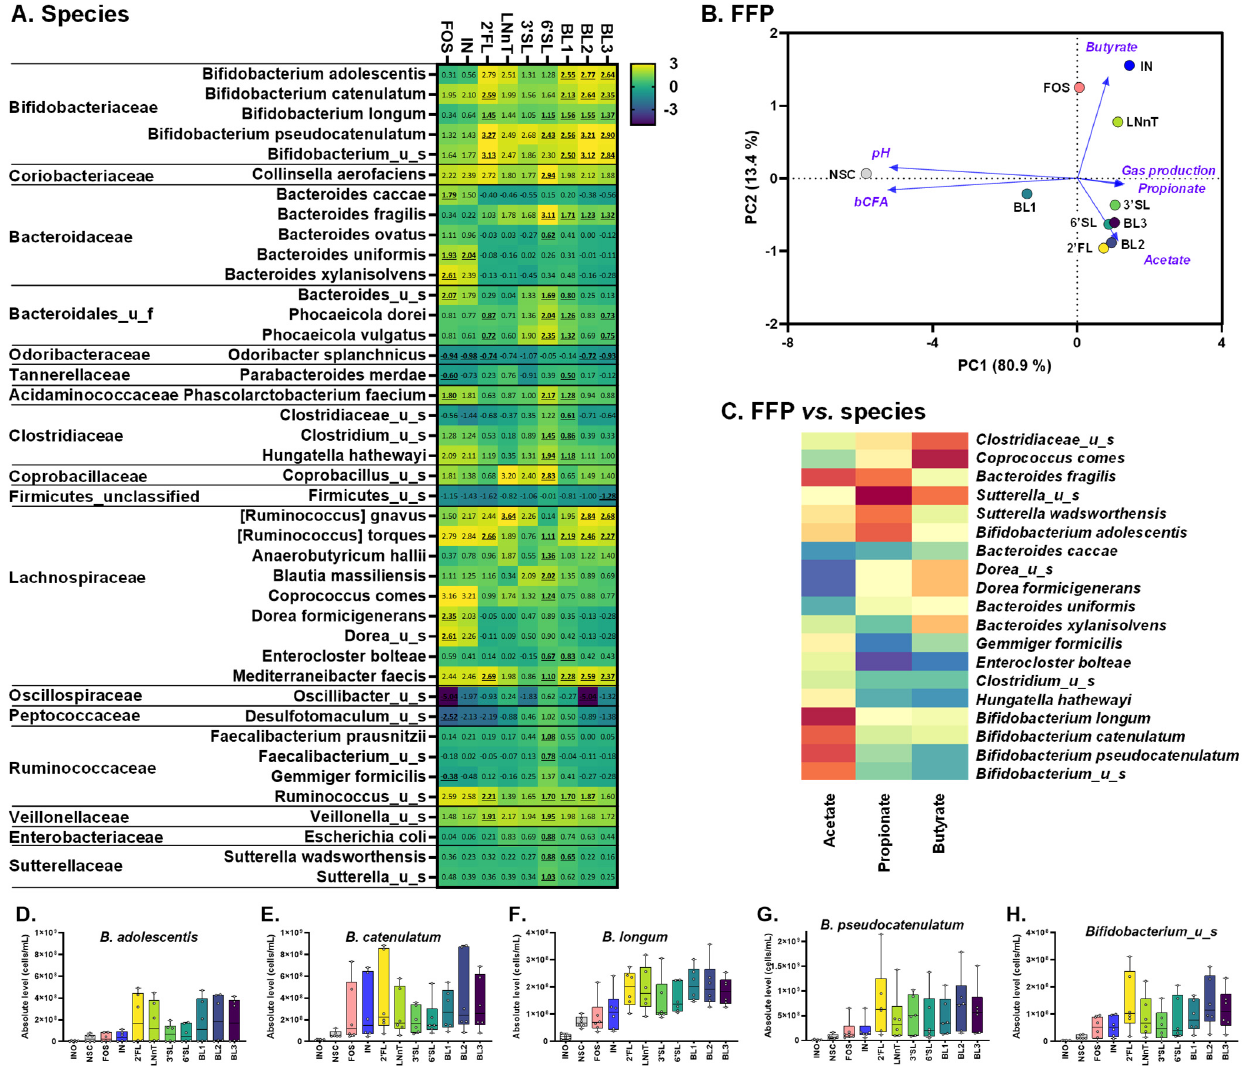
Figure 4. HMOs exerted a remarkable e ff ect on Bi fi dobacterium species when supplied to the children’s microbiota, in contrast to fructans. Impact of single HMOs (2 ′ FL, LNnT, 3 ′ SL, 6 ′ SL), mixtures thereof (BL1, BL2, BL3) and reference prebiotics (FOS and IN) on microbial composition at species level at 24 h upon initiation of treatment, as tested with the ex vivo SIFR ® technology for 6-year-old children. ( A ) Heatmap representing average values of microbial taxa ( n = 6) that were signi fi cantly a ff ected by any of the treatments (FDR = 0.10), expressed as log2(ratio treatment vs. NSC). Signi fi cant di ff erences are indicated by bold and underlining. ( B ) PCA summarizing treatment effects on fundamental fermentation parameters, based on the average data across donors ( n = 6). ( C ) Regularized Canonical Correlation Analysis (rCCA) (cut o ff = 0.65) to highlight correlations between short-chain fa tt y acids (acetate, propionate, butyrate) and signi fi cantly a ff ected species. ( D – H ) Box plots representing the abundances (cells/mL) of di ff erent Bi fi dobacterium species. INO = inoculum; NSC = no substrate control; 2 ′ FL = 2 ′ Fucosyllactose; LNnT = Lacto-N-neotetraose; 3 ′ SL = 3 ′ Sialyllactose; 6 ′ SL = 6 ′ Sialyllactose; BL1/2/3 = HMO Blend 1/2/3; IN = inulin; FOS = fructooligosaccharides.